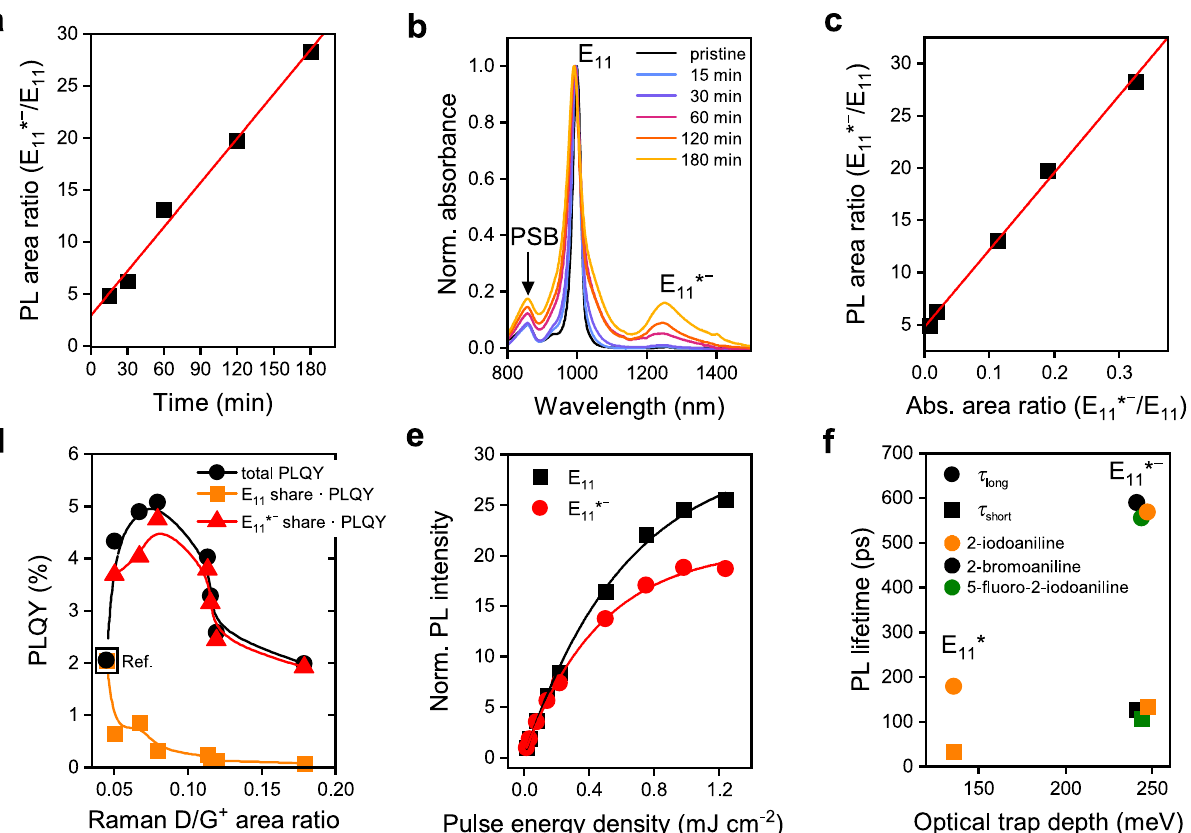
Fig. 2 Spectroscopic characterization of functionalized (6,5) SWNTs. a – e (6,5) SWNTs functionalized with 2-iodoaniline in the dark. a Integrated E 11 * − /E 11 emission ratio vs. reaction time with linear fi t. b Absorption spectra of functionalized (6,5) SWNTs normalized to E 11 transition, showing phonon sideband (PSB, ~860 nm) and E 11 * − absorption band (~1247nm) increasing with reaction time. It is noteworthy that a broadening of the E 11 * − defect absorption band may occur due to a scattering background caused by increasing aggregation of SWNTs at very high defect densities. c Integrated E 11 * − /E 11 emission vs. E 11 * − /E 11 absorbance ratio with linear fi t. d Photoluminescence quantum yield (PLQY) of functionalized SWNTs (total and separated into spectral shares of E 11 * − and E 11 ) vs. integrated Raman D/G + ratios as metric for defect density (lines are guides to the eye). e Normalized intensity of E 11 * − (red) and E 11 (black) emission vs. pulse energy density, indicating faster saturation of defect state than band-edge exciton emission. f PL lifetime ( τ long , − defects created by functionalization of (6,5) SWNTs with 2-iodoaniline (orange), 2-bromoaniline (black), and τ short ) vs. optical trap depth for E 11 * and E 11 * 5- fl uoro-2-iodoaniline